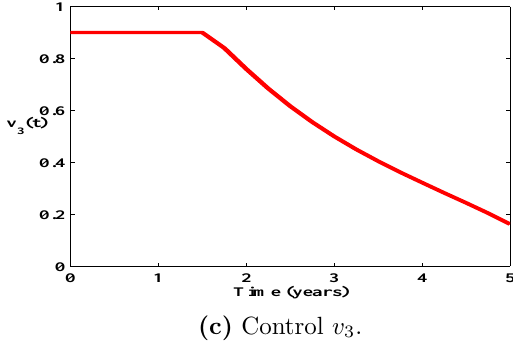
Figure 7. Controls v 1 ( t ), v 2 ( t ) and Figure 6. Number of E , I and L v 3 ( t ) when each one is used alone. with control v 3 and without control. At this point, it can be concluded that in terms of reducing E , I and L simultaneously, the pre- vention control v is the most efficient when only 1 one control is used. However, combining controls Figure 7 represents the optimal controls when is potentially more effective than using any one each one is used alone. In this figure we can see alone. Different combinations of optimal controls that full effort on v is applied during almost the 1 and strategies ( v with v , v with v , . . . ) can be 1 2 2 3 entire control period. The control v is also fully 2 used to achieve other objectives depending on the used but only for the first 2 . 5 years and then de- particularity of the disease in each country. creased smoothly. We also observe that the con- trol v is the least used. 3